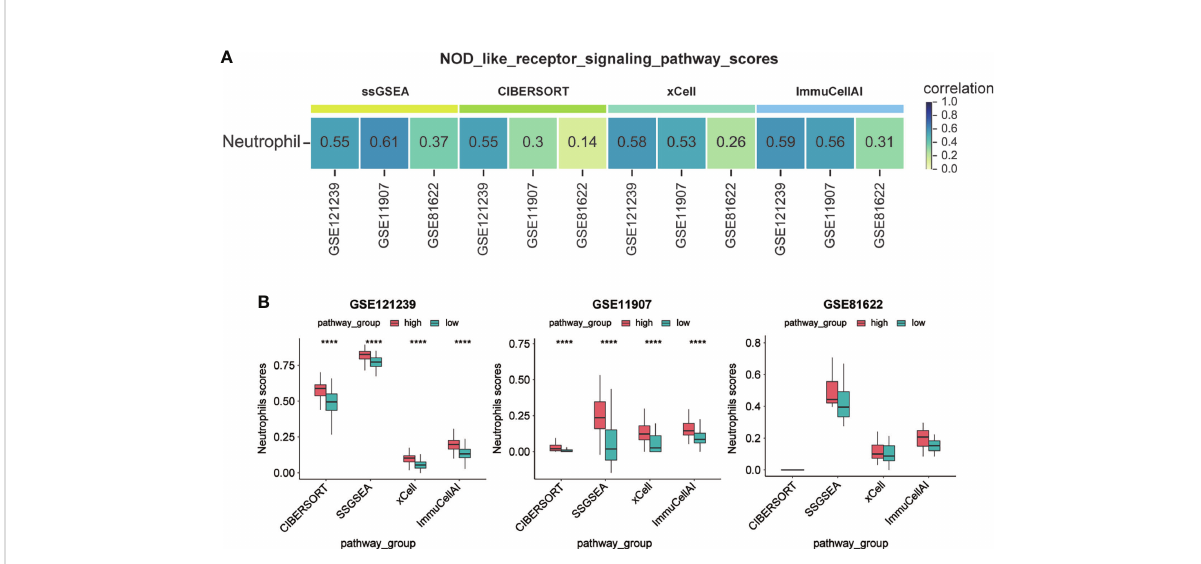
FIGURE 9 Activation of NOD-like receptor signaling pathway promoted neutrophil in fi ltration. (A) Correlation between NOD-like receptor signaling pathway scores and Neutrophil in fi ltration scores. (B) Comparison of Neutrophil in fi ltration scores between high and low subgroups of the NOD-like receptor signaling pathway scores. (****P